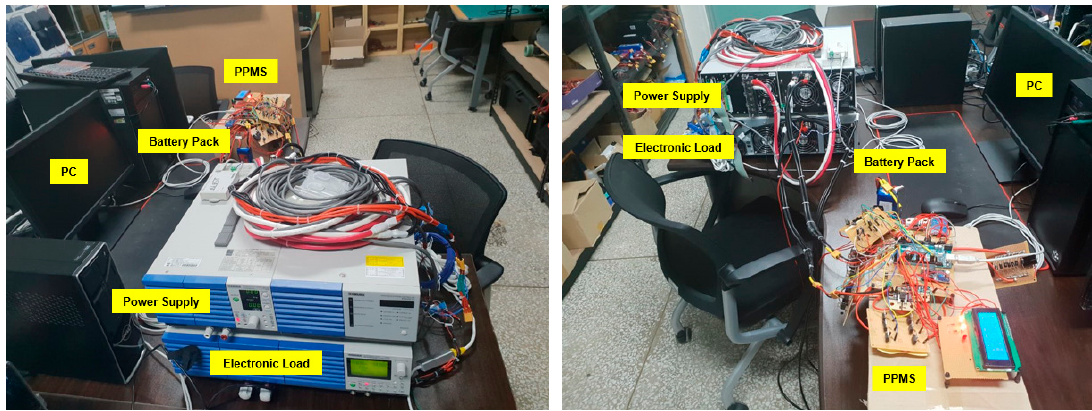
Figure 12. Experiment setup.